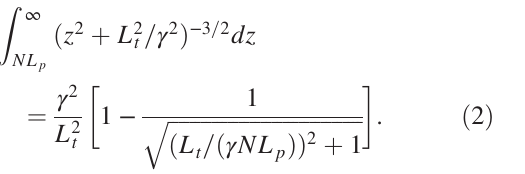
ffiffiffiffiffiffiffiffiffiffiffiffiffi p 1 − β 2